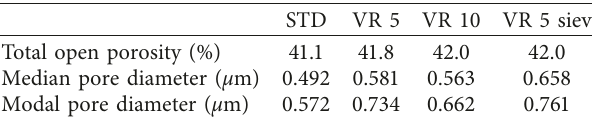
Figure 5: Relative (a) and cumulative (b) pore size distribution of FCBs. Table 1: Porosity characterization of